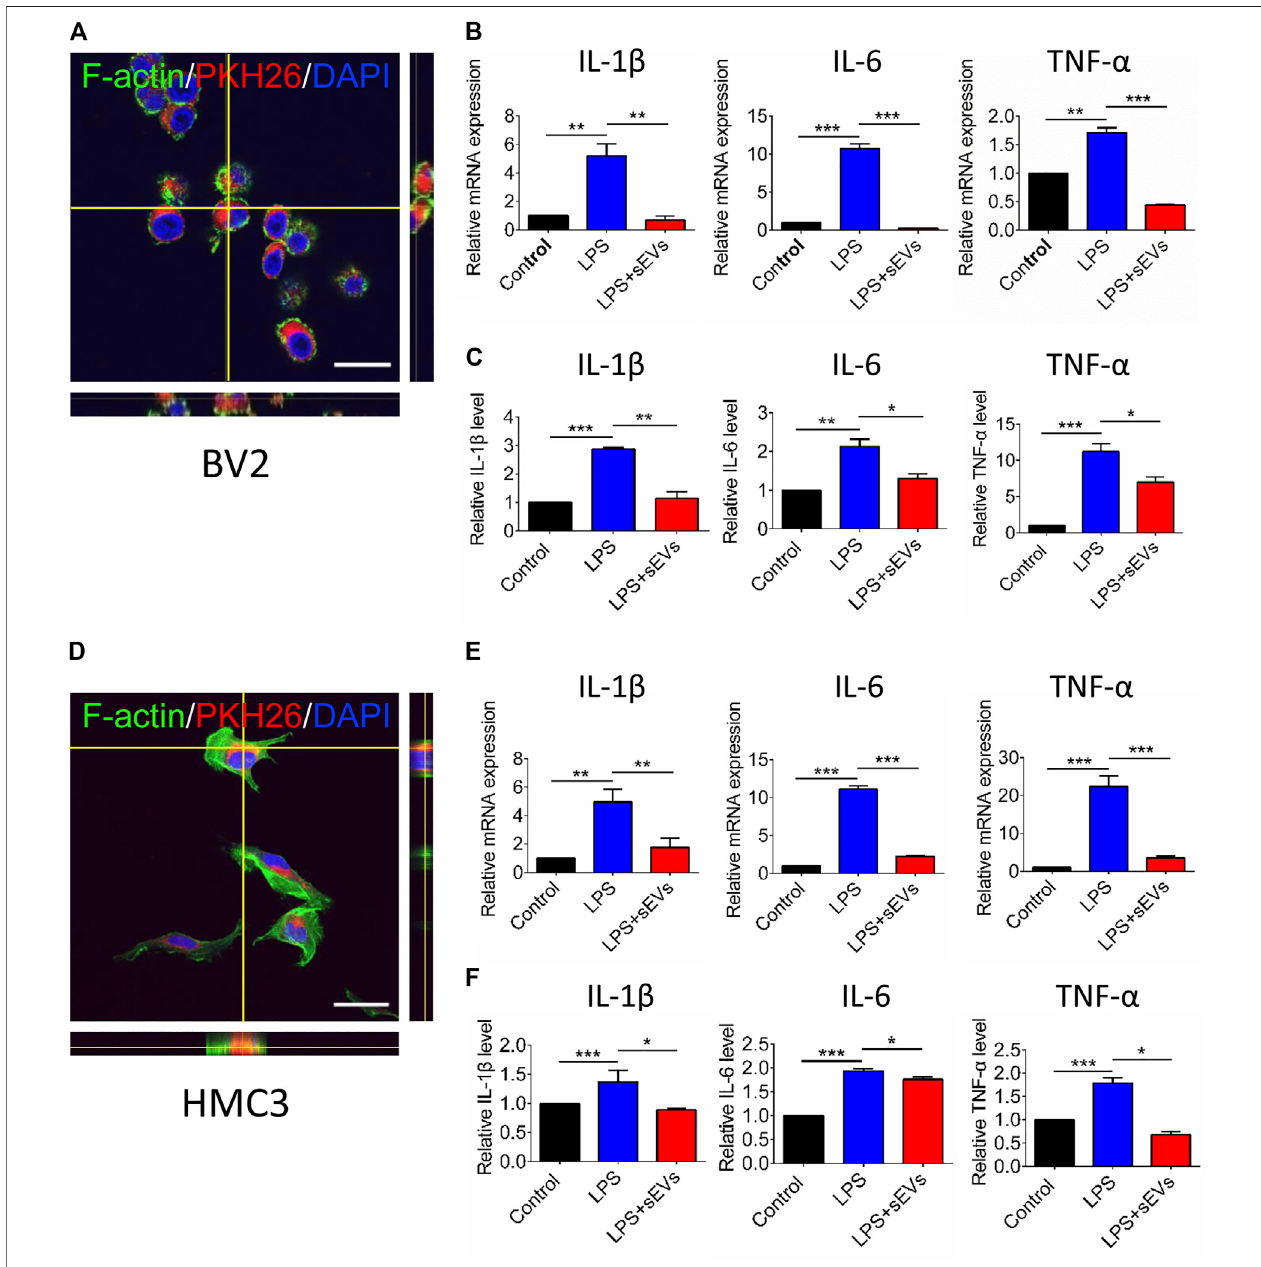
FIGURE 5 | Microglia phagocytosis assay of hRPC-sEVs and cytokines changes after LPS stimulation of microglia. Representative confocal images showing the hRPC-sEVs (red) in the medium are located with Factin-labeled mouse (A) or human (D) microglia cells (green). Enlarged orthogonal view shows that the cytoplasm of microglia contains a large number of hRPC-sEV particles after LPS stimulation. Scale bar, 50 μ m. Real-time qPCR analysis showing relative mRNA expression of cytokinesIL-1 β ,IL-6,andTNF- α inculturedmousemicroglia (B) andhumanmicroglia (E) .AnalysisofcytokineconcentrationssuchasTNF- α ,IL-6,andIL-1 β inthe supernatant of mouse microglia (C) and human microglia. (F) Culture detected by ELISA. Data are shown as means ± SD. * p < 0.05, ** p < 0.01, and *** p < 0.001.